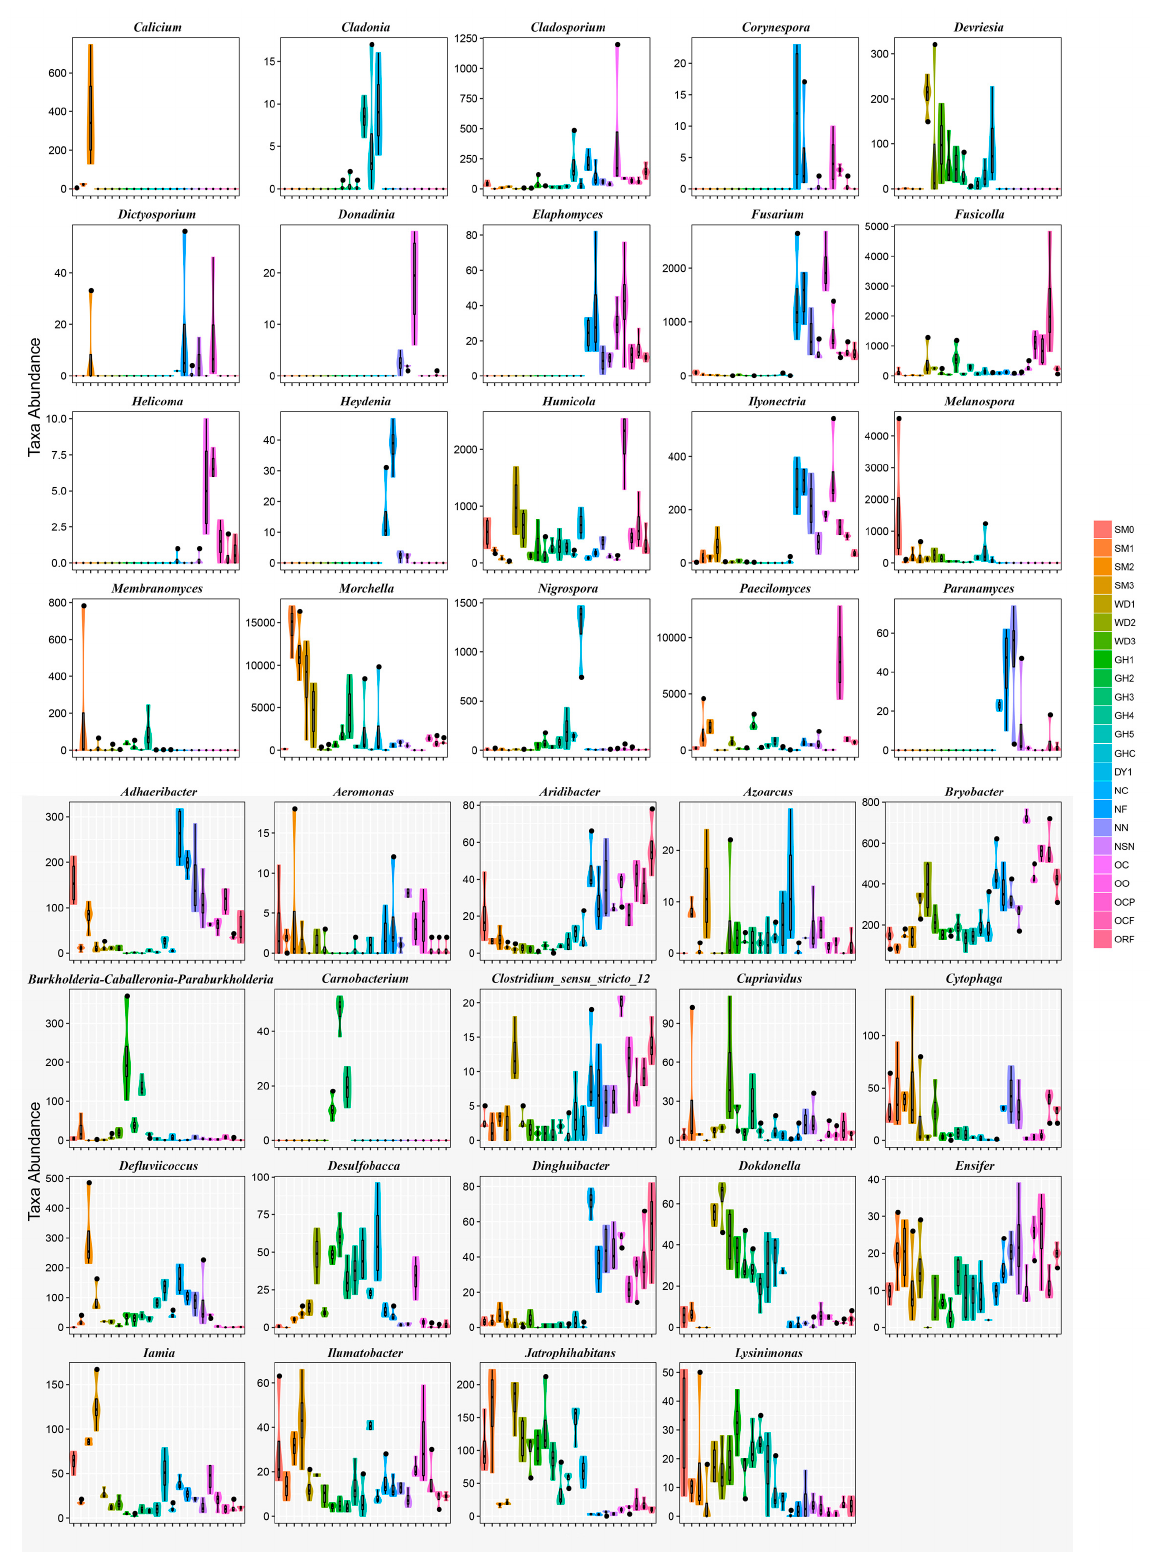
Figure 3. Metastats analysis in all soil samples. The abscissa is the first 39 taxa with the most significant difference, and the ordinate is the sequence quantity of each taxon in each sample. The “fat and thin” of “violin” reflects the level of density of sample data distribution (the wider width indicates more samples corresponding to this sequence